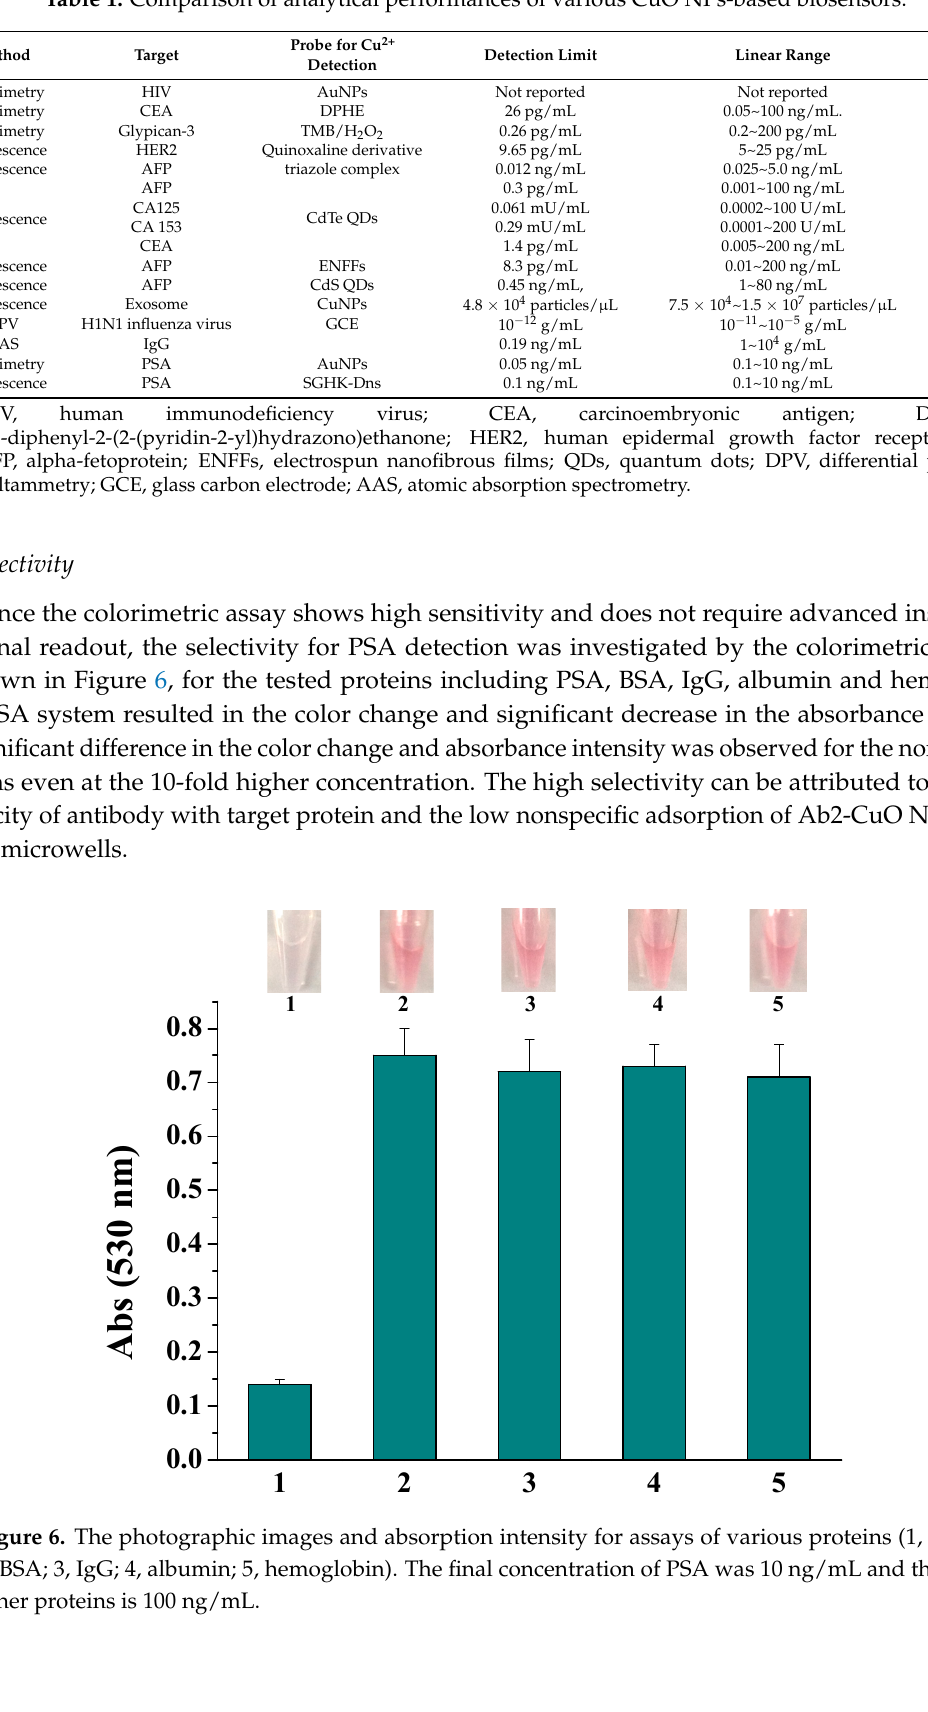
Table 1. Comparison of analytical performances of various CuO NPs-based biosensors.